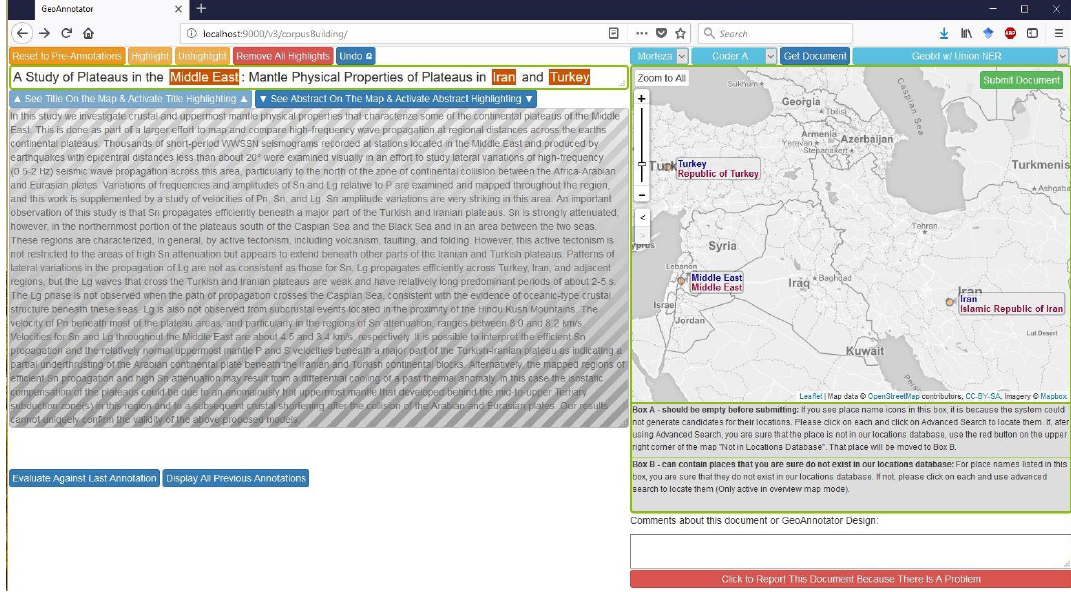
Figure 7. GeoAnnotator’s UI main window layout, with the first document part (title) being active with place names highlighted in text ( left panel ) and mapped to the toponyms ( right panel ). The user can modify highlights or click on each toponym on the map to assign a tag or see alternative candidates. On the map, place names in text are labeled in blue, while the toponym official name from the gazetteer (sometimes identical, but often longer) is labeled in red.